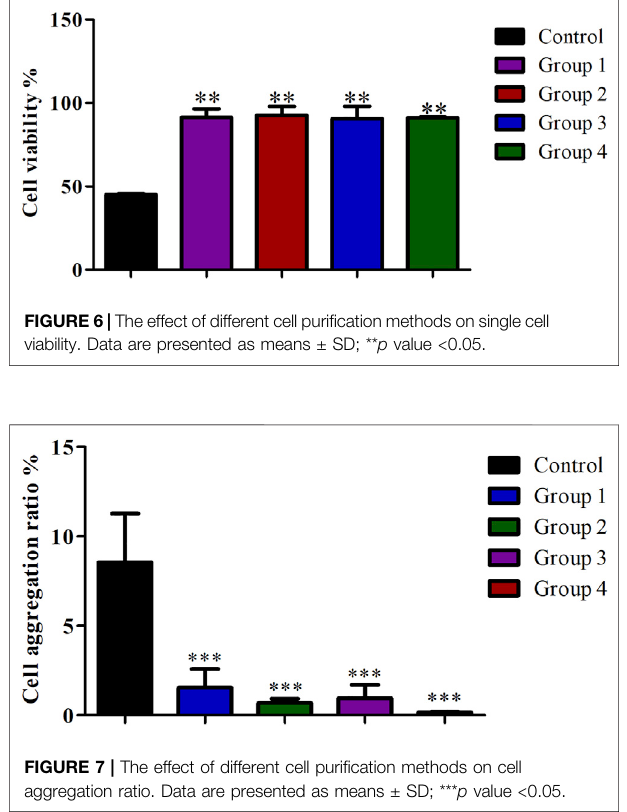
Frontiers in Cell and Developmental Biology |